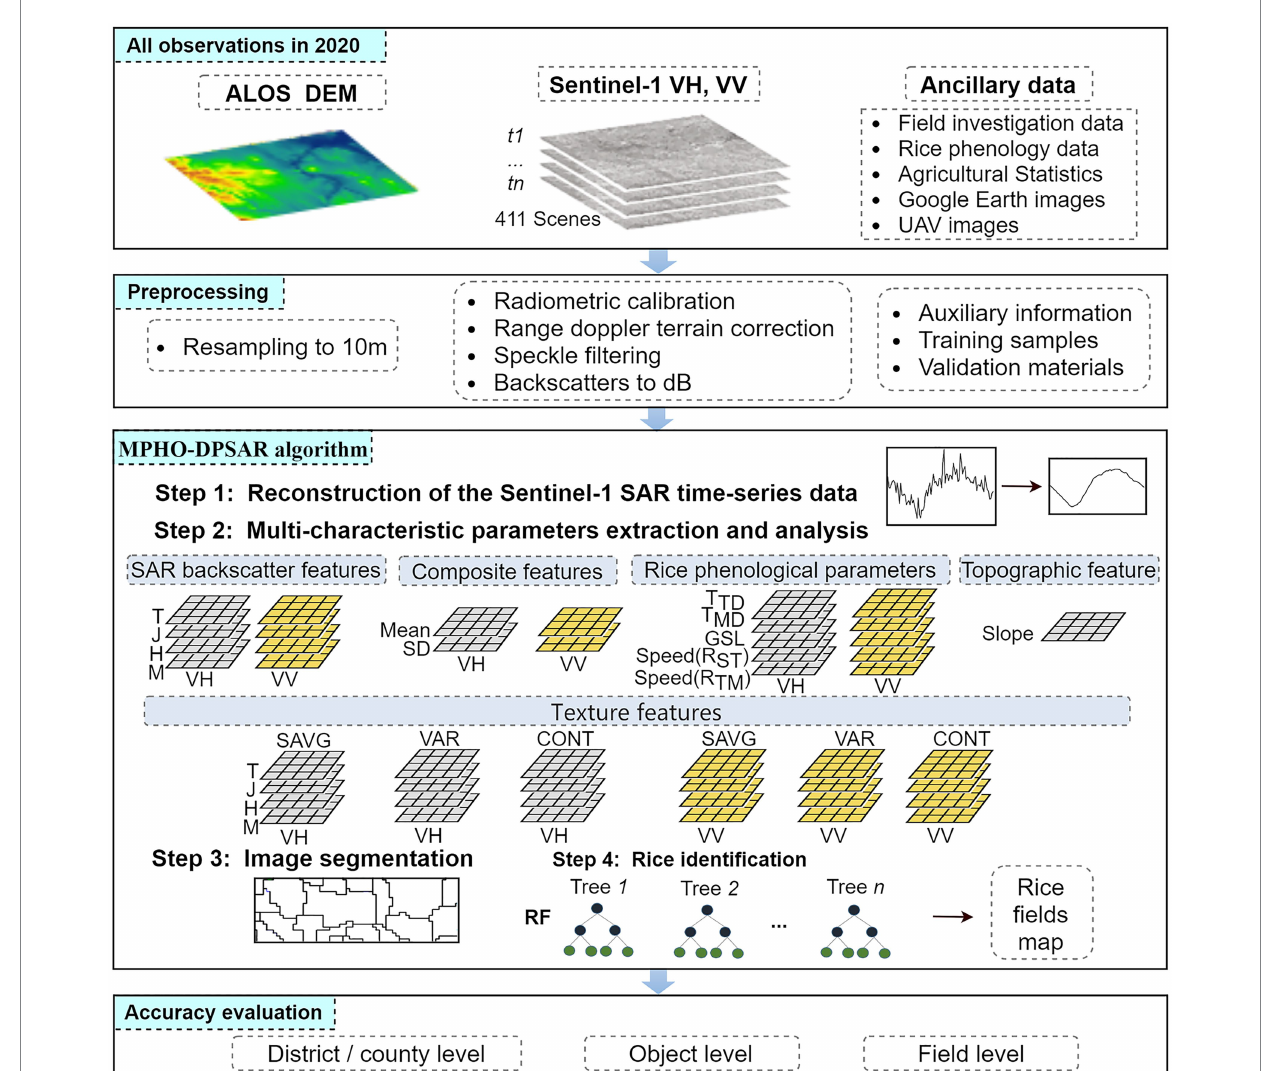
FIGURE 2 Schematic flow of MPHO-DPSAR method, T, J, H, and M denote the rice transplanting, jointing, heading, and mature stage,